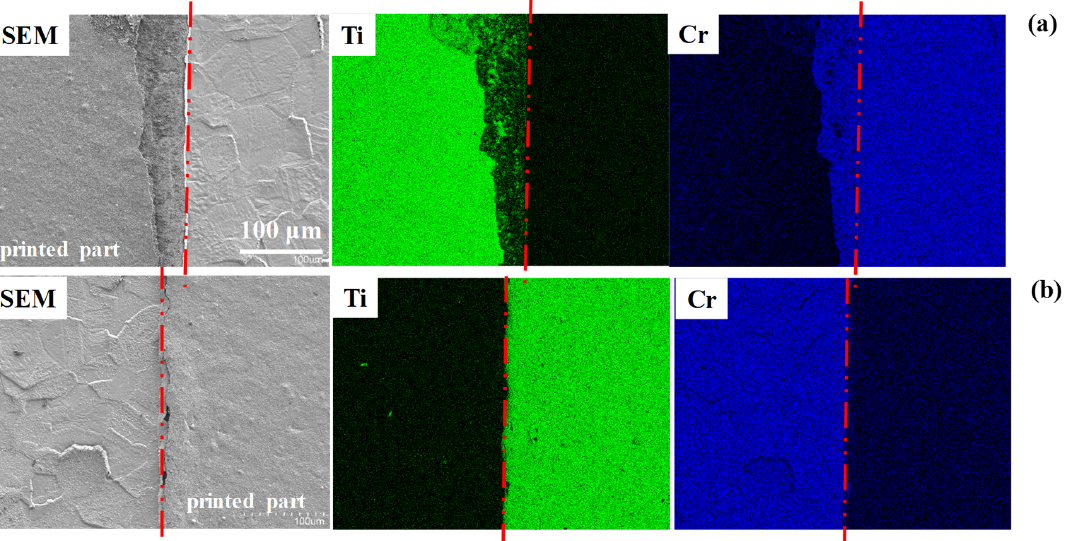
Figure 6. SEM-EDX analyses on the selectively nitrided substrate surface. ( a ) SEM image and element mapping of Ti and Cr at the A-region in Figure 5a and ( b ) SEM image and element mapping of Ti and Cr at the B-region in Figure 5b.